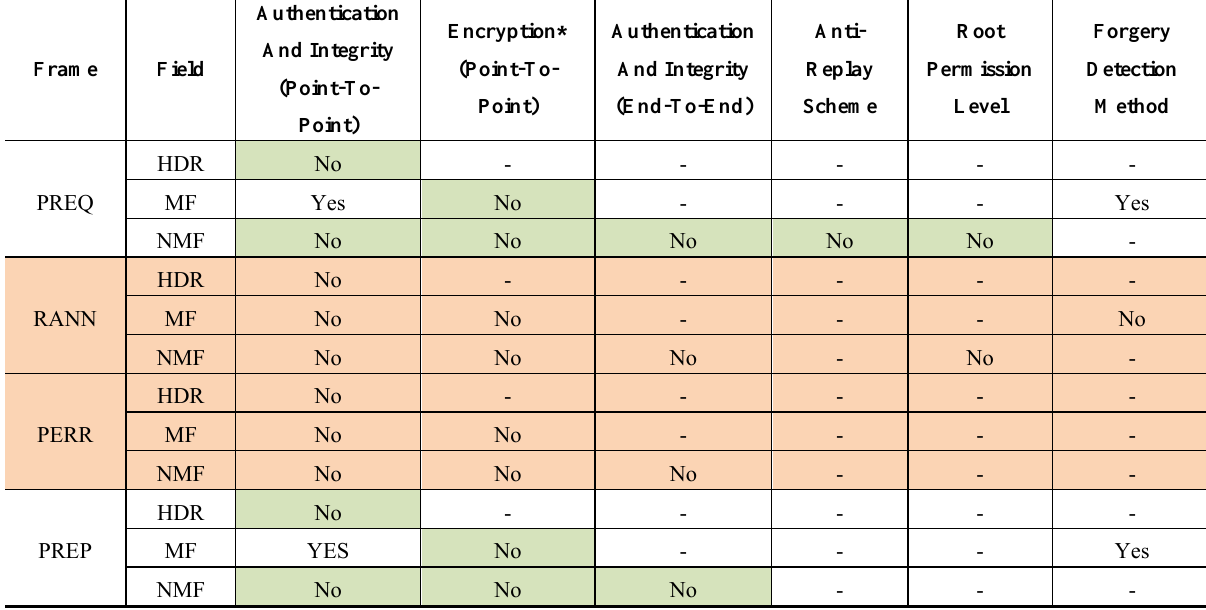
Table 12. Security services provided by IBC-HWMP and